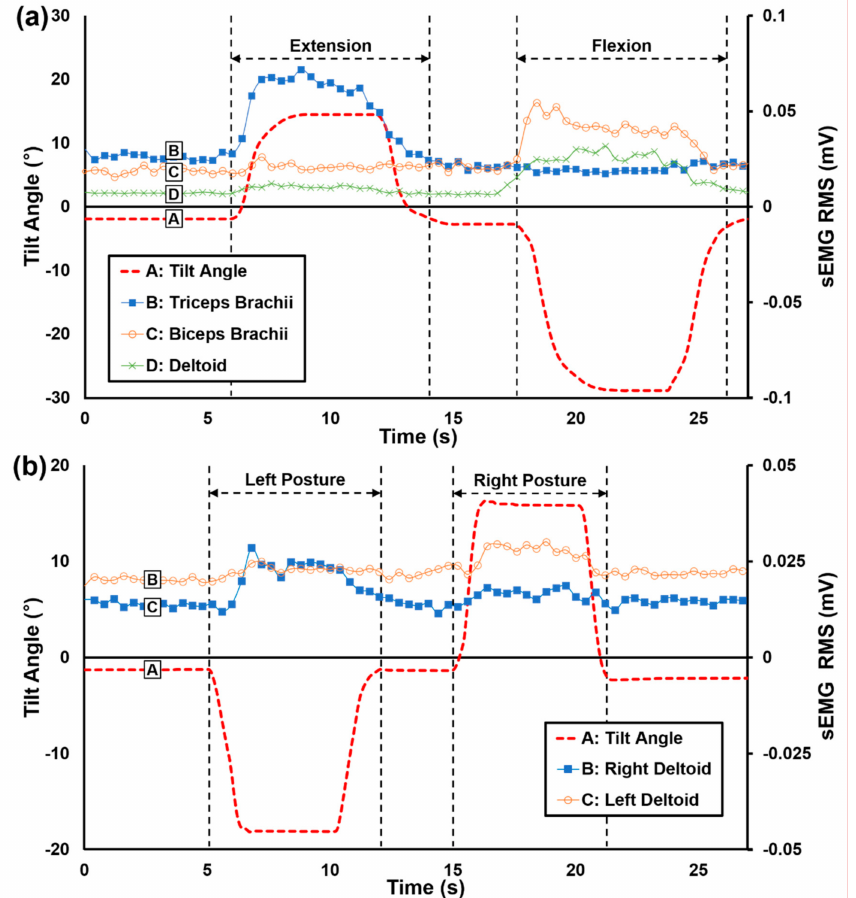
Figure 8. The sEMG signal data corresponding to the tilting angles of the balance handle: ( a ) extension and flexion; ( b ) pronation and